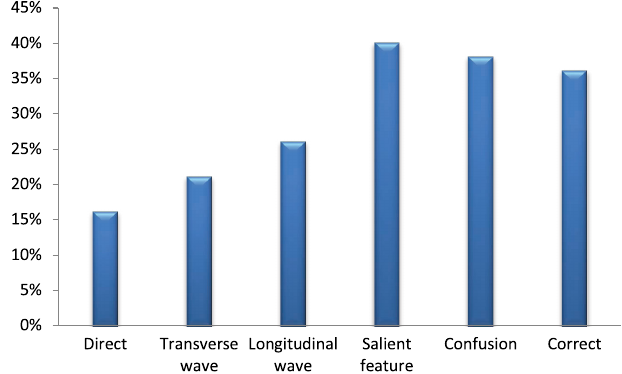
FIG. 2. Distribution of answers among the